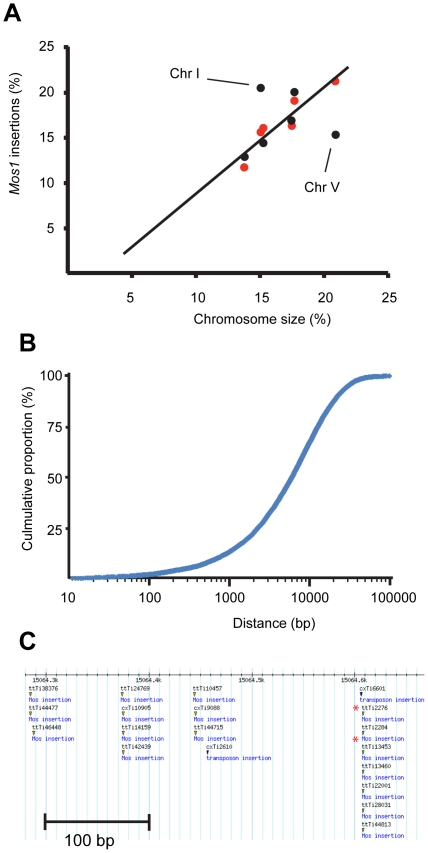
Distribution of Mos1 alleles.(A) Graph showing the relationship between chromosome length (as a percentage of the whole nuclear genome) and the proportion of Mos1 alleles per chromosome reported in a previous study [5], and the 10,858 alleles obtained in the current project (black and red circles, respectively). The outliers, concerning chromosomes I and V, from the previous study are highlighted with lines. (B) Distribution of distances from one Mos1 allele to the next, in a 5′ to 3′ direction along each chromosome. The graph shows the cumulative percentage of alleles that are separated by less than the indicated distance. (C) Concentration of Mos1 alleles at the extreme right end of chromosome I (length 15,072,423 bp). The separation of the allele numbers indicates that almost all the alleles were generated independently, except in two cases (ttTi2276 and ttTi2284; ttTi13453 and ttTi13460), highlighted by an asterisk. This region was also preferentially targeted during the previous study as reflected by the presence of several cxTi alleles.